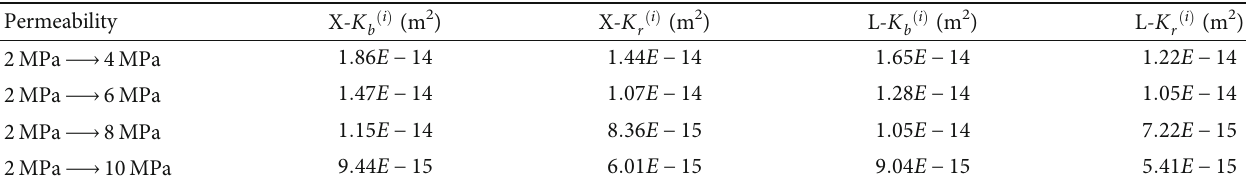
Table 7: The permeability evolution during the loading-unloading process with the axial strain 1.72%.